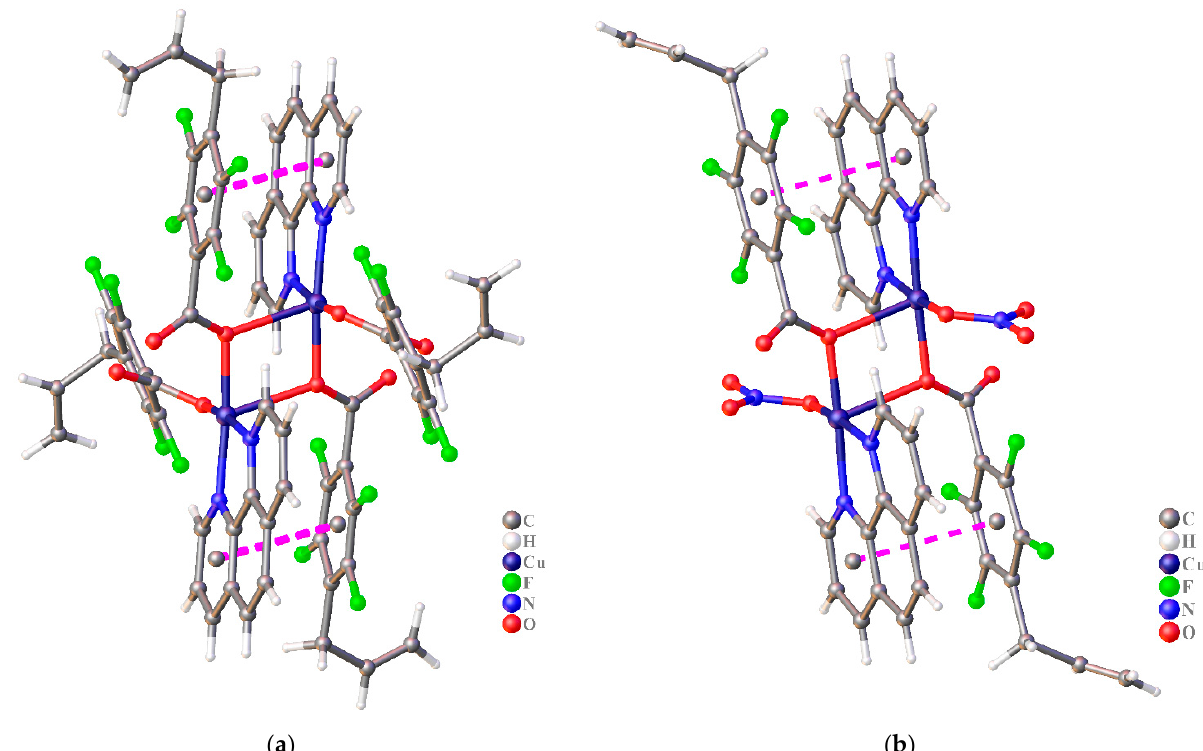
Figure 5. Molecular structure of 5 ( a ) and 6 ( b ) in crystals. The dotted line shows π ··· π interactions. The binuclear complexes 5 and 6 are structurally similar to the binuclear fragments “cut out” from the chain of polymers 1 and 2 , respectively. Cu-Cu distances are 3.435(2) Å and 3.3642(9) Å, Cu–O bonds are in the range of 1.97–2.37 Å and 1.93–2.38 Å in complexes 5 and 6 , respectively, and the Cu–N bonds in both complexes are about 2 Å long. The tetragonal-pyramidal environment of each copper atom (CShM = 2.073( 5 ), 2.687( 6 )) in complex 5 is formed by two nitrogen atoms of the chelate-coordinated 1,10-phenanthroline molecule, two common oxygen atoms of µ 2 κ O-Afb anions, and by an intrinsic oxygen atom of the κ O monodentate-coordinated Afb anion. In complex 6, the place of the monodentately coordinated carboxylate anion is occupied by the monodentately coordinated nitrate anion. The arrangement of the π -systems of ligands in the structure of 5 is such that an intramolecular π ··· π interaction occurs between phenanthroline and the aromatic fragment of one of the tetrafluoro-4-allyl benzoate anions with a distance between the planes of the interacting fragments of 3.4083(12) Å (Figure 6). The aromatic fragment of the second anion is spatially deployed with respect to the other two ligands, as in the above-described cadmium coordination polymer, as a result of which it does not enter into π ··· π interactions, forming C-H ··· π and C-F ··· π contacts (Figure S6, Tables S2 and S3). With such a structure of the complex, the second side of phenanthroline remains free of intramolecular interactions, resulting in an intermolecular stacking interaction with a distance between the planes of phenanthroline fragments of neighboring molecules of 3.451(2)